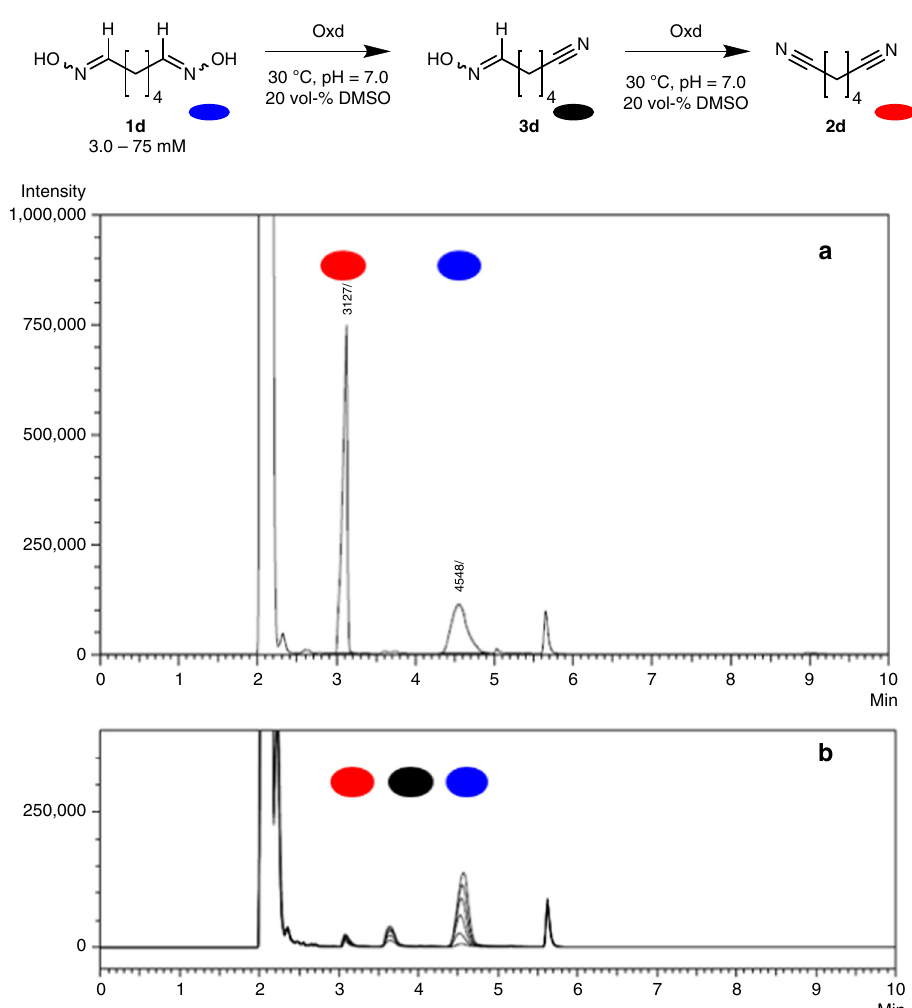
Fig. 4 Postulated two-step dehydration of α , ω -dialdoximes to α , ω -dinitriles. a GC-chromatograms of a mixture of adiponitrile and adipaldehyde dioxime; b Overlay of GC-chromatograms illustrating the formation of the mononitrile-monooxime 3d as an intermediate in the biocatalytic dehydration of dialdoxime 1d using the aldoxime dehydratase OxdA (reaction time: 15